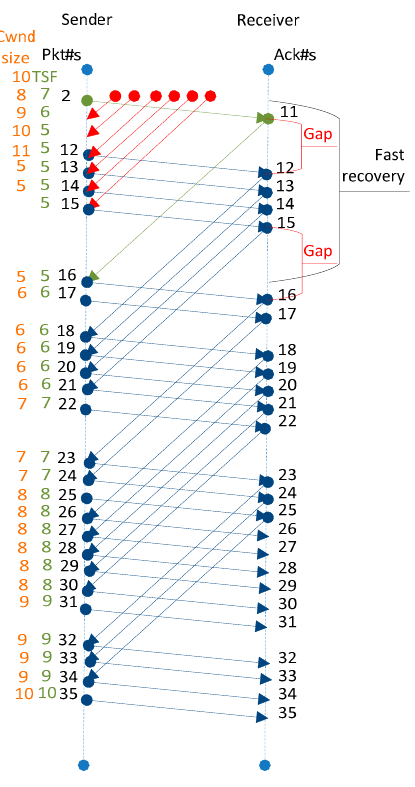
Figure 2. Illustration of congestion window management after fast retransmit and recovery.